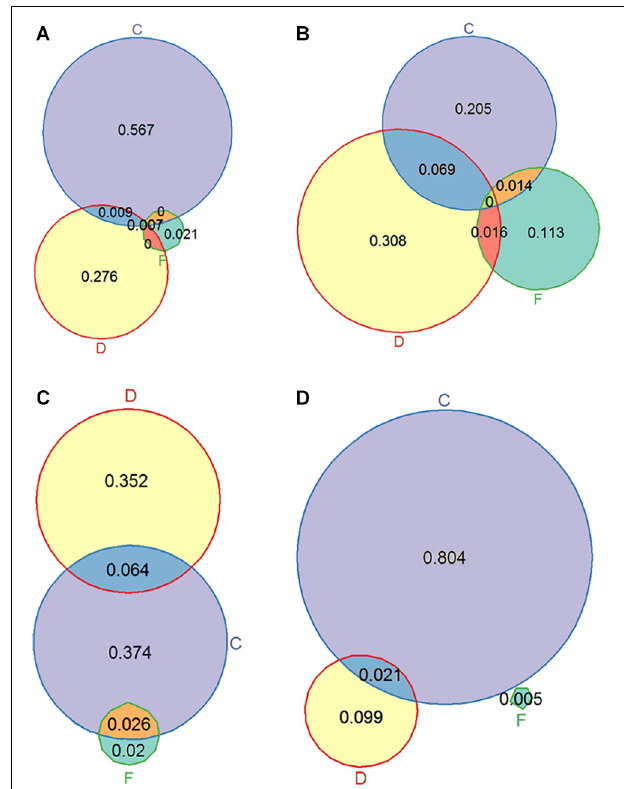
FIGURE 3 | Venn diagrams showing omega squared values representing the proportion of variance explained by CO 2 (C), flow (F), DOC (D) and their interactions for the variables relative growth rate (A) , length of the longest stem (B) , total plant chlorophyll (C) and leaf C:N ratio (D)